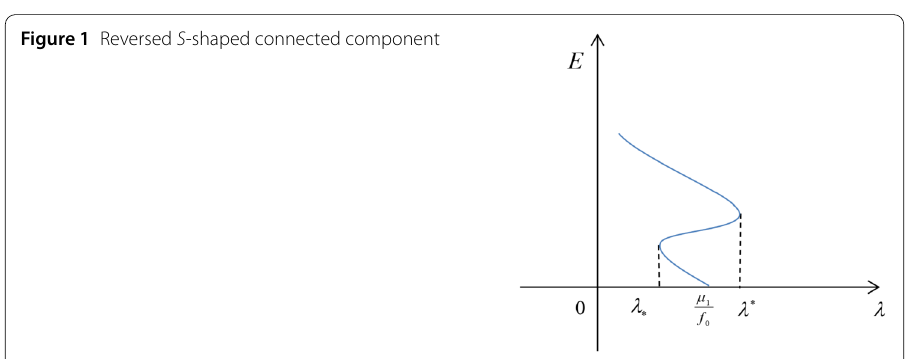
Figure 1 Reversed S -shaped connected